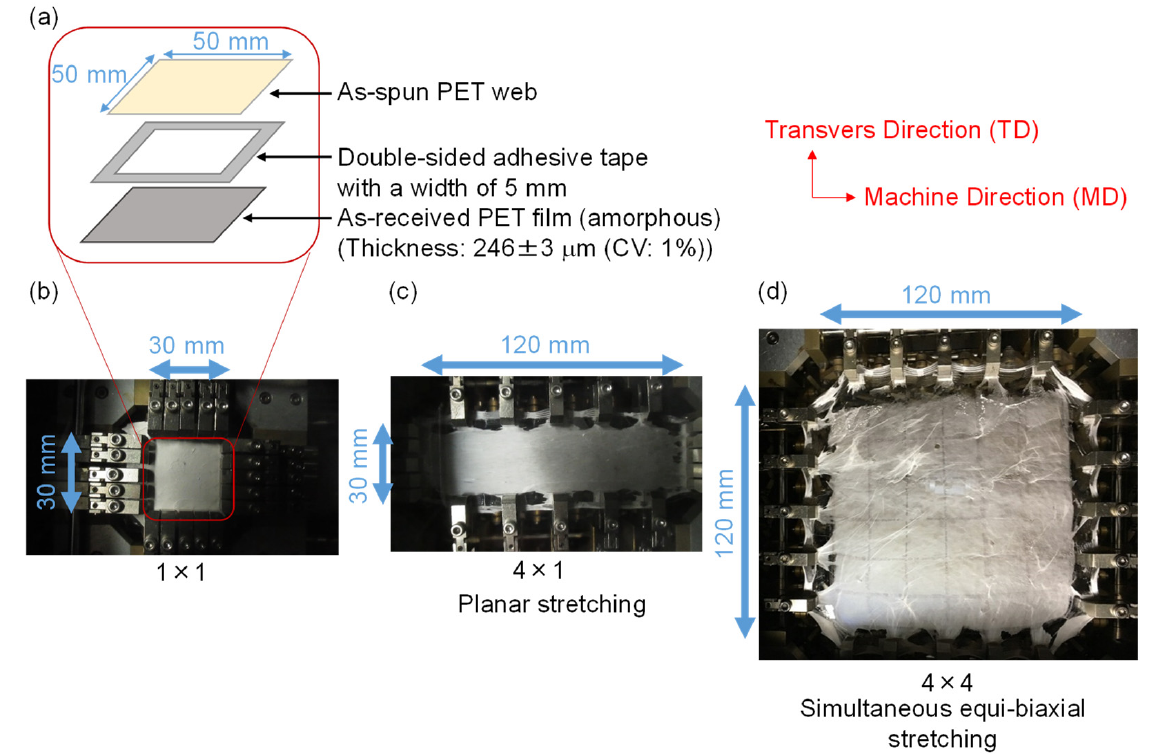
Figure 1. ( a ) Schematic for the preparation of web sample by stretching. Photographs of the samples in the oven ( b ) before stretching, i.e., MD (machine direction) × TD (transverse direction) = 1 × 1, and after planar and simultaneous equibiaxial stretching with the stretch ratios of ( c ) MD × TD = 4 × 1, and ( d ) MD × TD = 4 × 4.